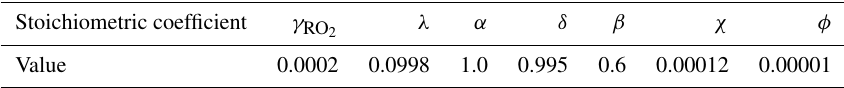
Table A2. Stoichiometric coefficients used in the model.